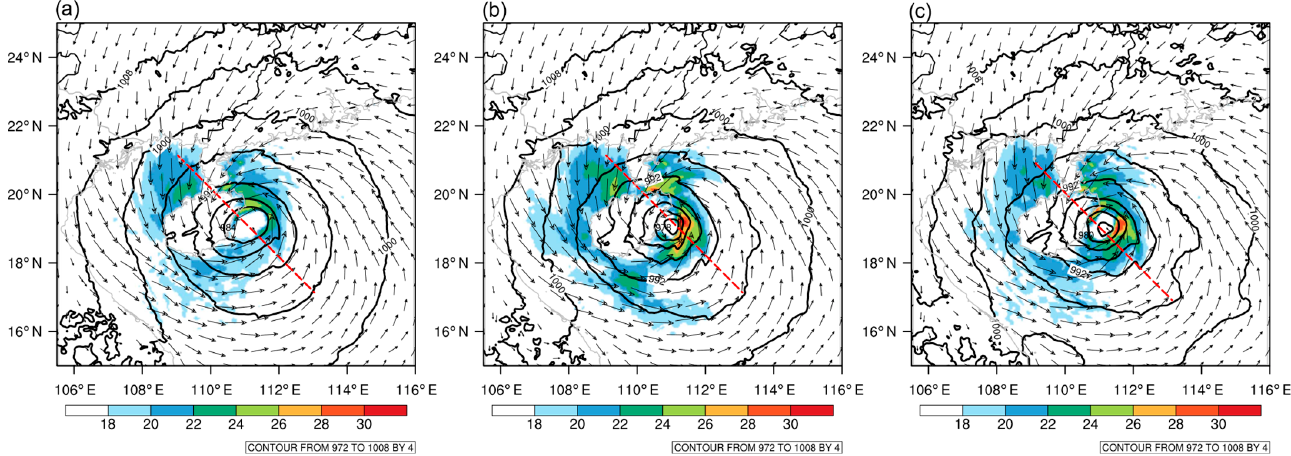
Figure 8. The surface wind vector, speed (shaded; units: m s-1) and sea level pressure (contour; units: hPa). ( a ) CTRL; ( b ) DA_ ψχ ; ( c ) DA_UV. Vertical cross sections are along red dotted lines.